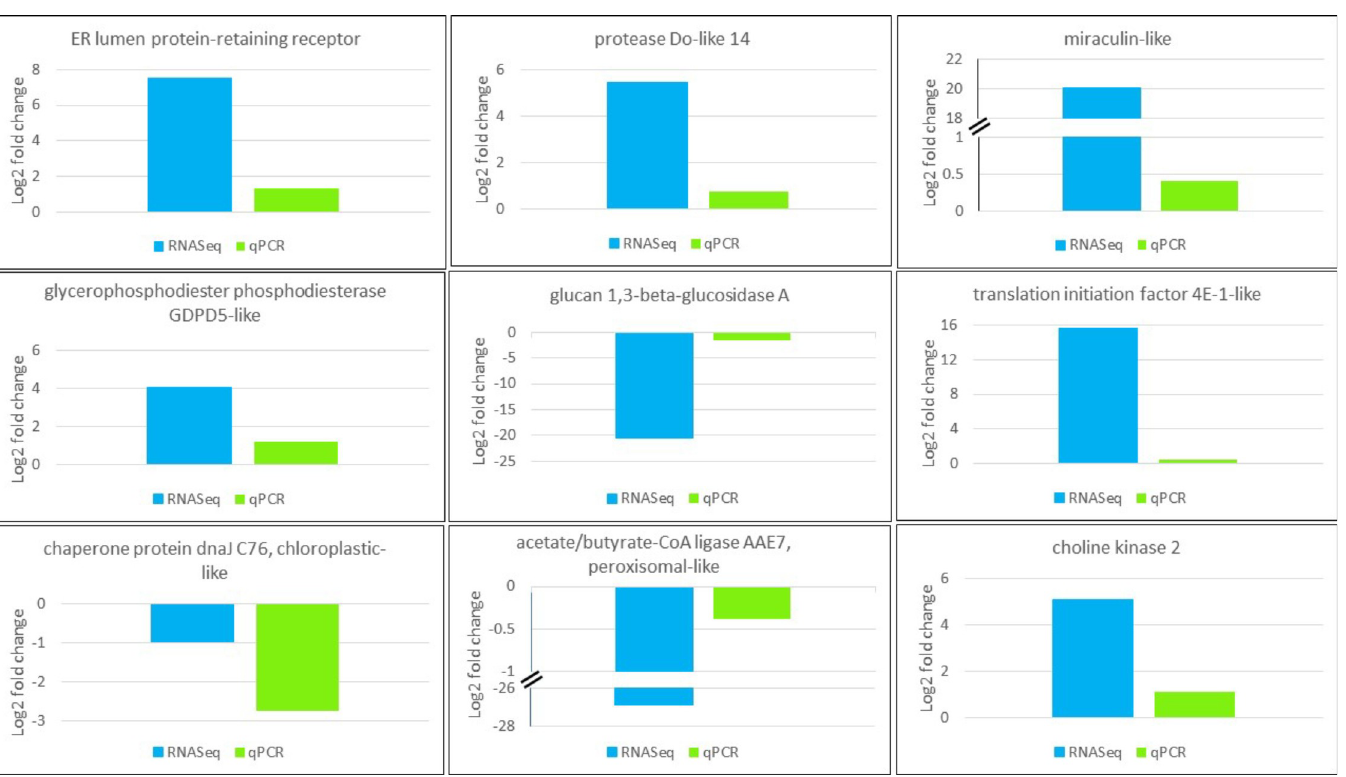
Fig 6. Validation of expression pattern of genes selected from RNASeq (blue) using RT-qPCR (green). CqEF1 α was used for gene normalization purpose. Gene function is shown on top of the plot.